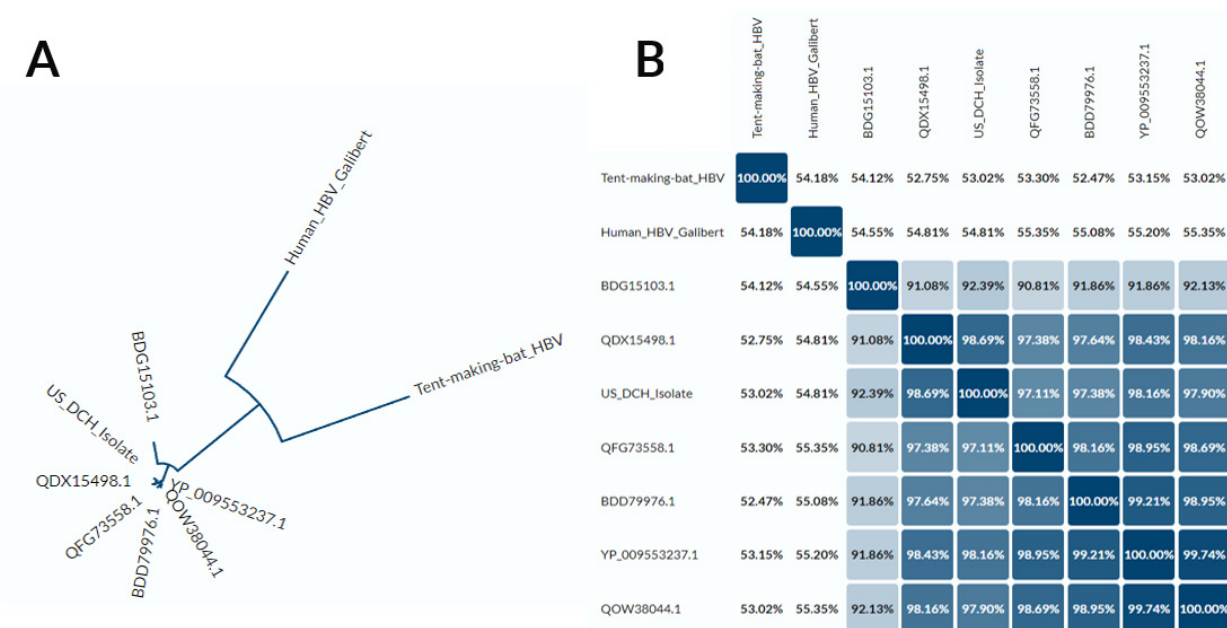
Figure 4. Phylogram ( A ) and identity matrix ( B ) based on the large surface protein sequence of DCH isolates, human HBV, and tent-making bat HBV. BDG15103.1 = Japan isolate 1 (Rara); YP_009553237.1 = Sydney isolate; BDD79976.1 = Japan isolate 2; QOW38044.1 = Thailand isolate;